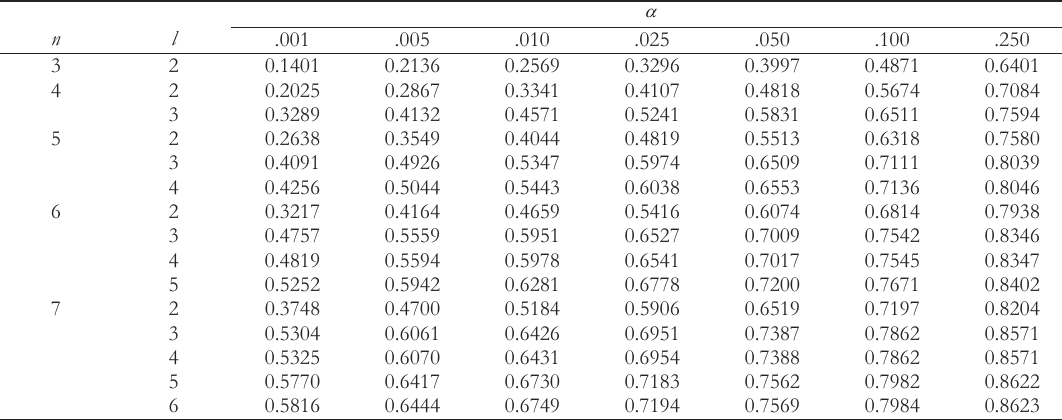
Critical values for Test 1 with SRSS data from the uniform distribution